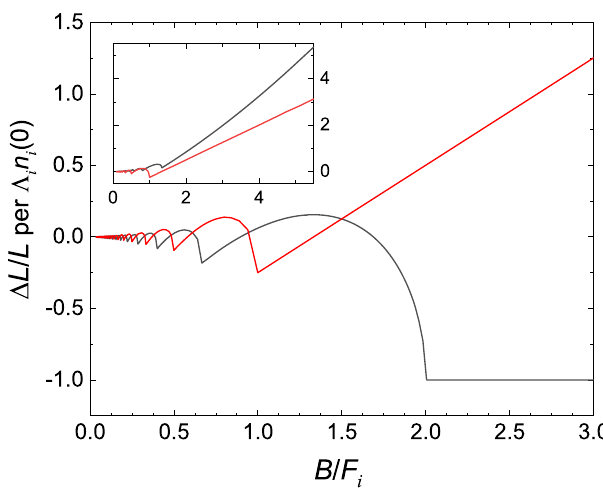
Fig. 1 The magnetostriction of the Weyl electrons (red) and of the trivial electrons with parabolic spectrum (black) versus magnetic induction B = μ 0 H at zero temperature. Here F i is de fi ned by Eq. (3), the magnetostriction Δ L / L iscalculated with equations of SupplementaryNotes 2 and 3.For the trivial electrons, the parameter δ isassumed to beequal tozero. Note the relative phase shift of the oscillations shown by the red and black curves. Inset: The similar plot, but when δ = 0.75 for the trivial electrons ffiffiffiffiffiffiffiffiffiffiffiffiffiffiffiffiffiffiffiffiffiffiffiffi u þ δ (cid:2) 0 : 5 (black line). In this case Δ L = L ¼ Λ i n i ð 0 Þð 0 : 75 u (cid:2) 3 = 2